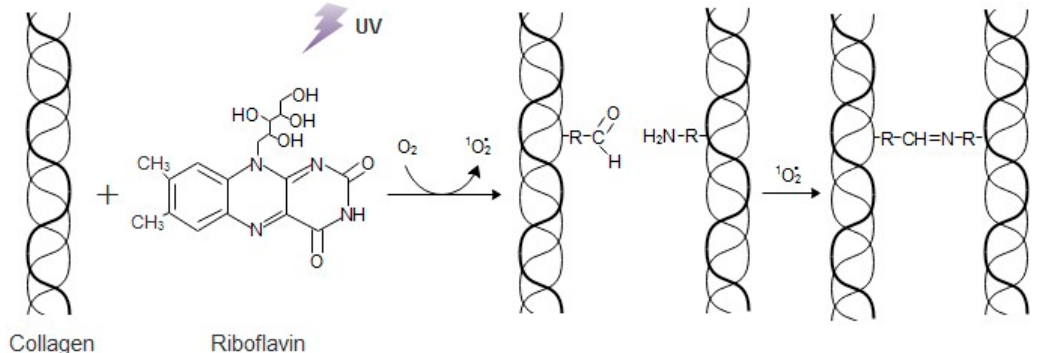
Figure 1. The interaction between collagen and riboflavin under UV irradiation.